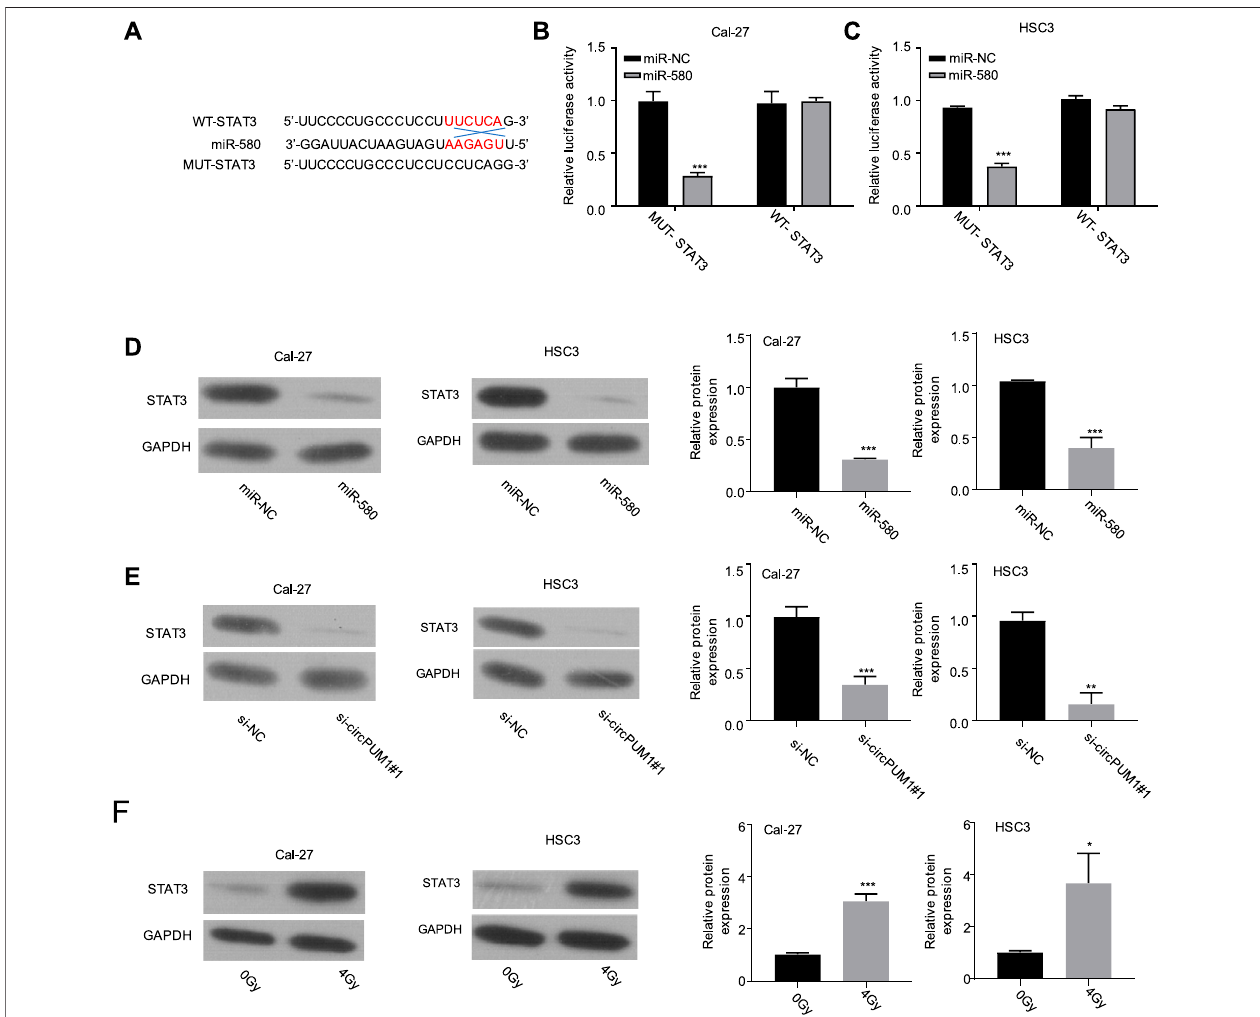
FIGURE 4 | Binding site of mir-580 and STAT3 (A) ; luciferase reporter gene assay veri fi ed the targeting relationship between mir-580 and STAT3 (B,C) ; protein expression level of STAT3 after mir-580 overexpression (D) ; knockdown of CircPUM1 and STAT3 protein expression in the OSCC cell line (E) ; expression of STAT3 in OSCC cells after 4 Gy irradiation (F) . p < 0.05 ( p ), p < 0.01 ( pp ), and p < 0.001 ( ppp